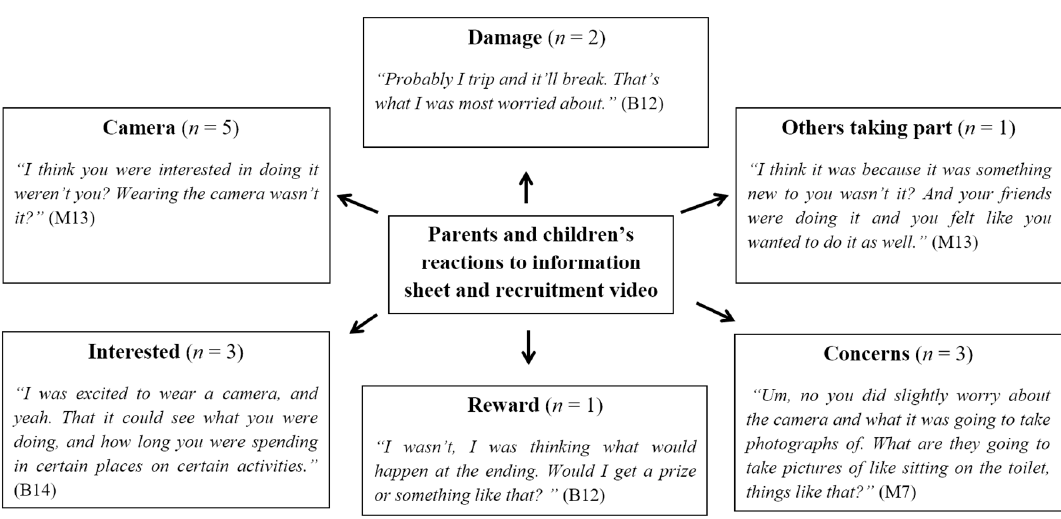
Figure 7. Pen Profile showing parents’ and children’s reactions to the information sheet and the recruitment video (B = Boy, G = Girl, F = Father, M = Mother); n shows the number of individual responses.